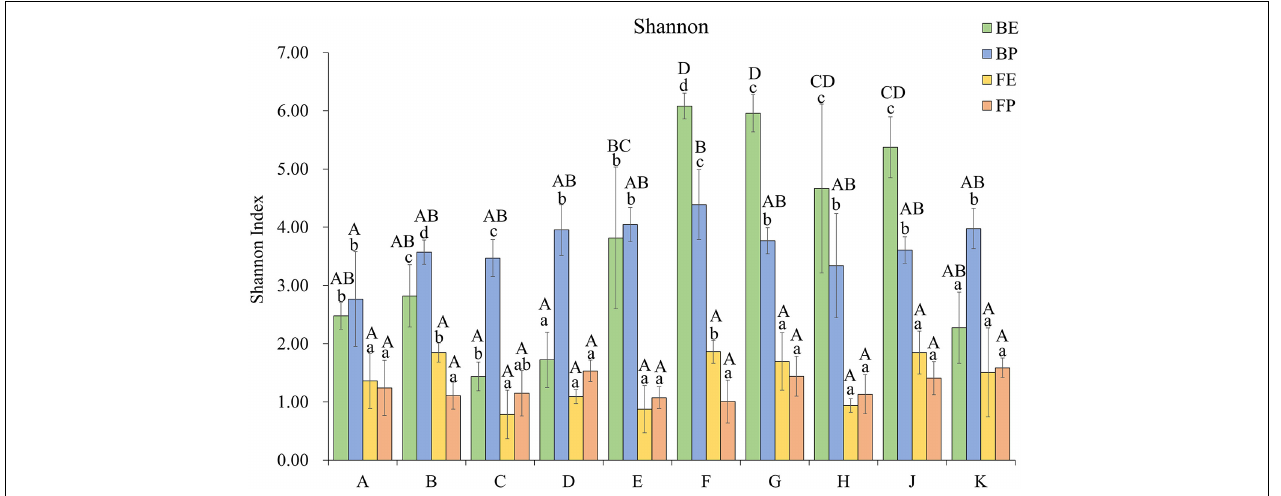
FIGURE 1 | Shannon indices of phyllosphere and endosphere microbial communities from ten different rice cultivars. BE, endophytic bacteria; BP, phyllosphere bacteria; FE, endophytic fungi; FP, phyllosphere fungi. The capital letters designate significant differences ( P < 0.05) between different cultivars and the lowercase letters represent significant differences ( P < 0.05) among different samples of the same cultivar (BE, BP, FE, and